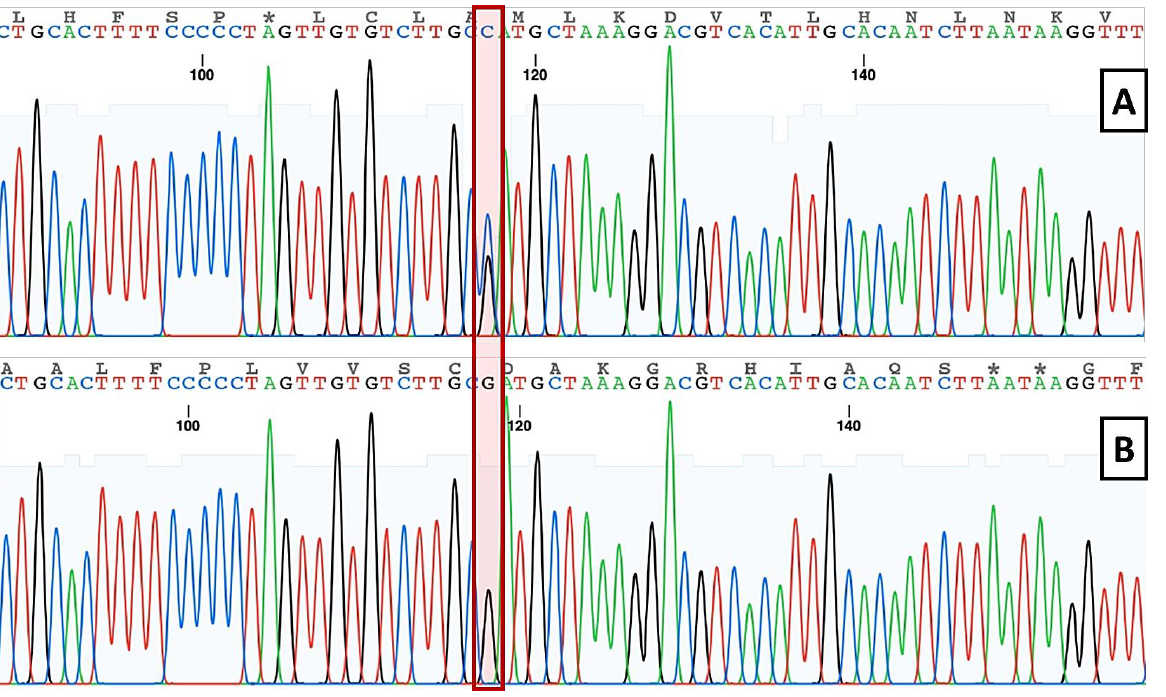
Figure 4. Identification and genotyping of SNP using direct sequencing method for confirmation: ( A ) chromatogram of GC genotype (heterozygote); ( B ) chromatogram of GG genotype (major ho- mozygote).